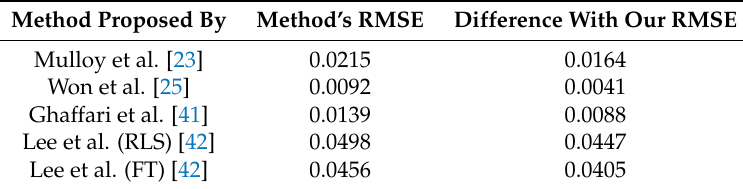
Table 5. RMSE comparison of the proposal with similar